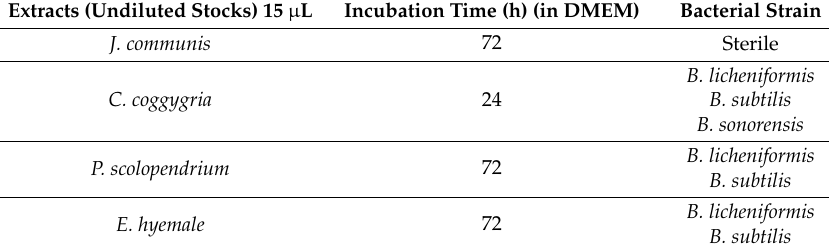
Table 2. Bacterial strains in